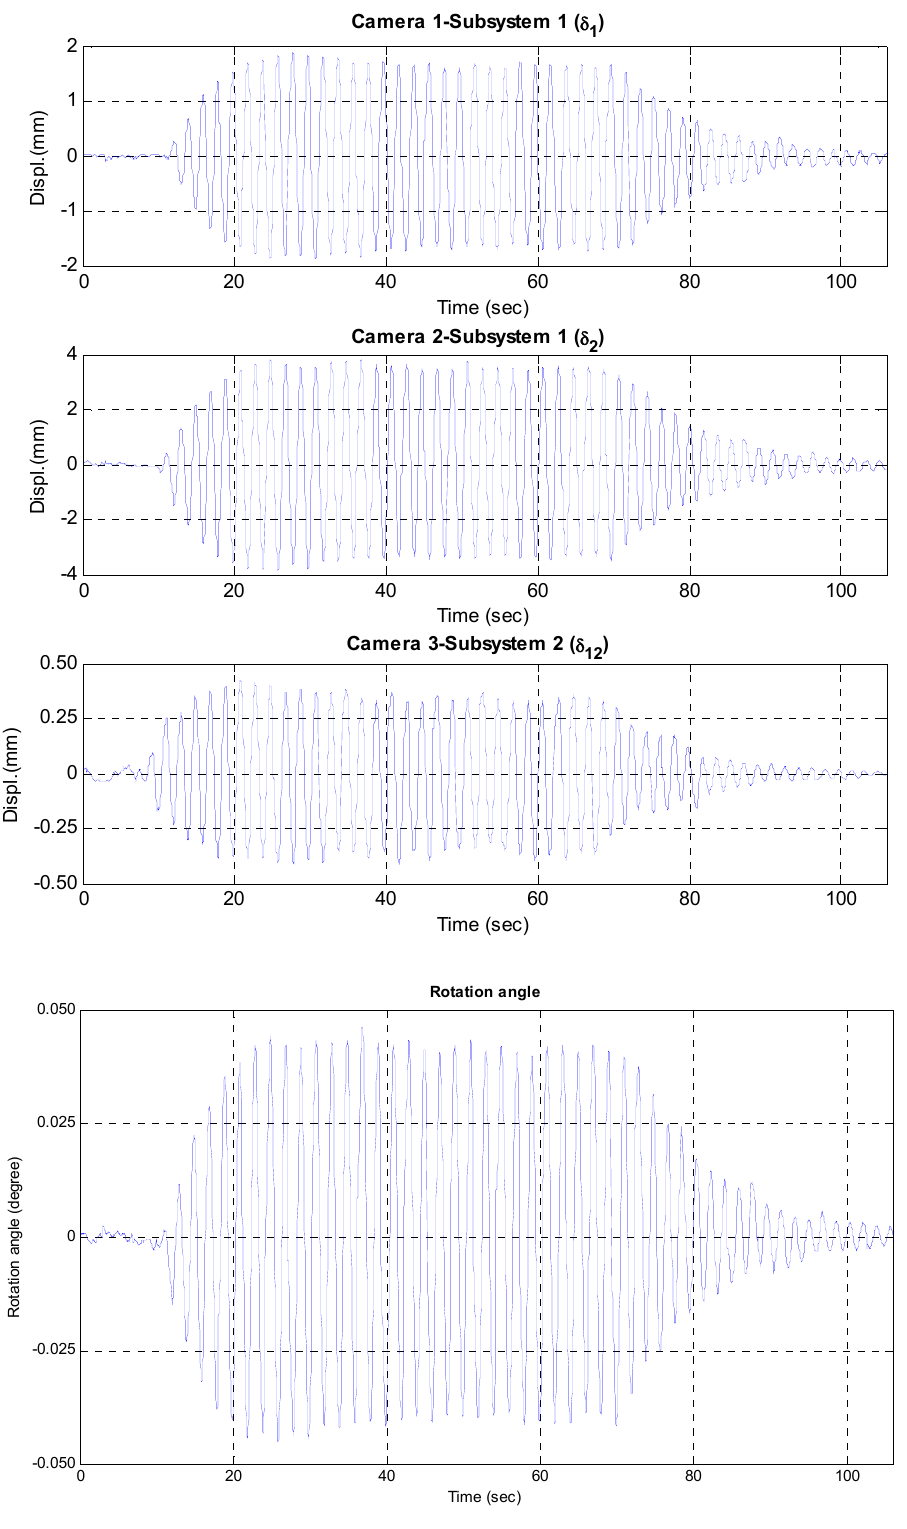
Figure 6. Measured and estimated data under sinusoidal